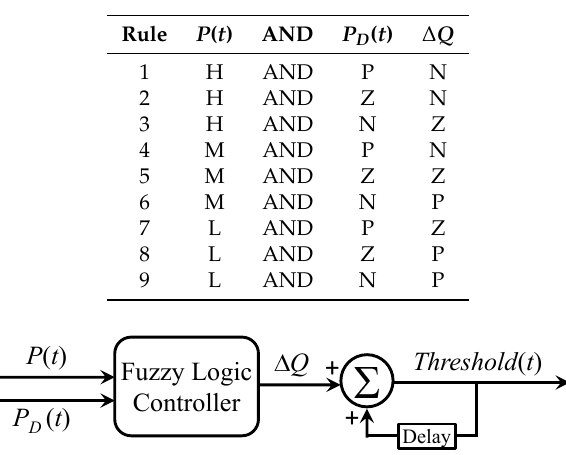
Table 4. Inference rules of proposed fuzzy logic.